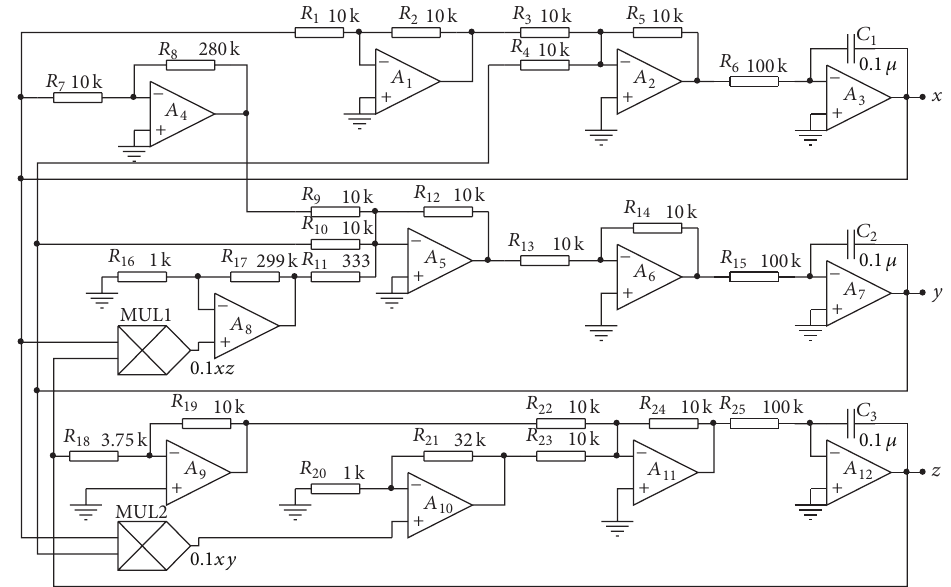
Figure 6: The original circuit design.